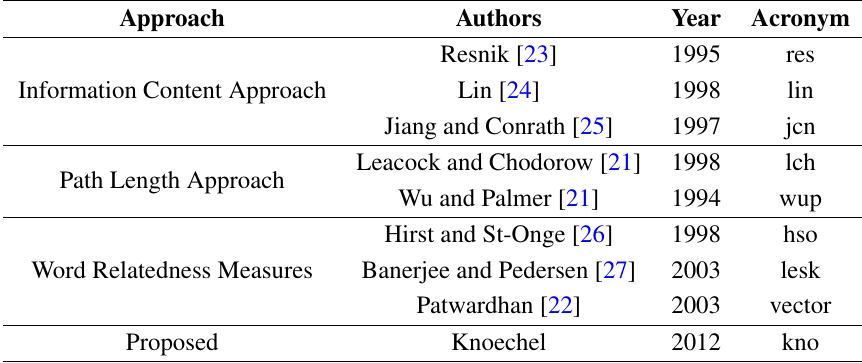
Table 2. Summary of approaches to defining word relatedness using